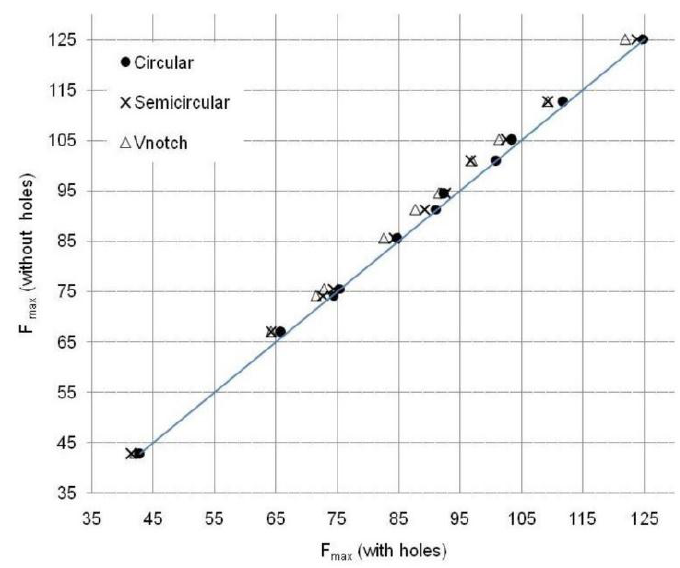
Figure 11. Comparison of load for a 3%b 0 indentation in joints with and without vent holes.